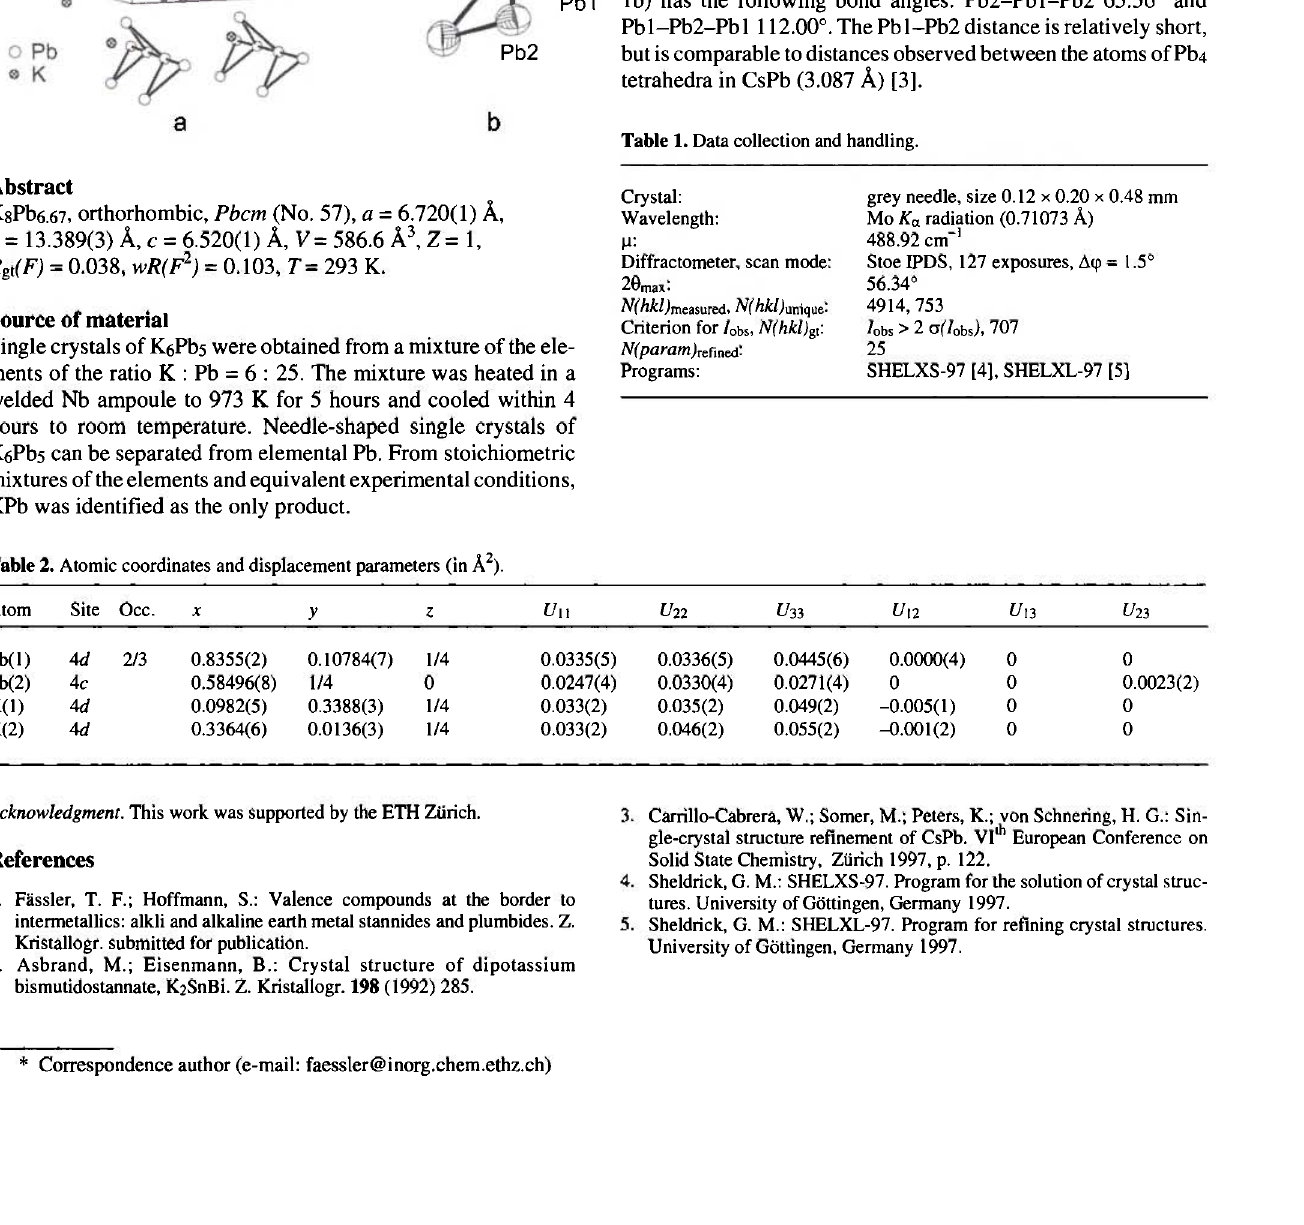
Table 1. Data collection and handling. Crystal: